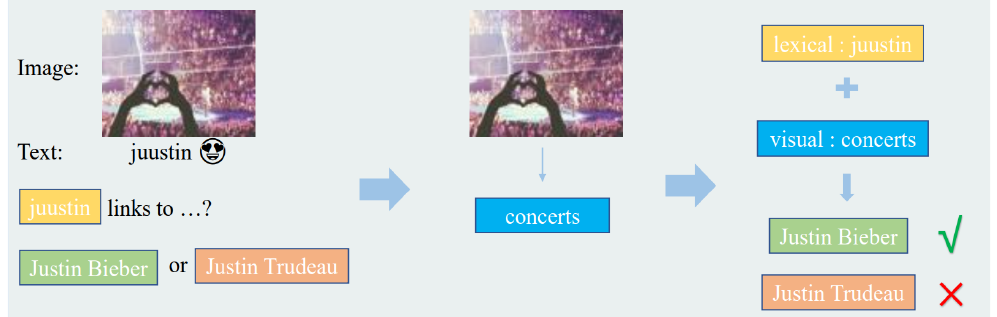
Figure 8. Illustration of multimodal entity